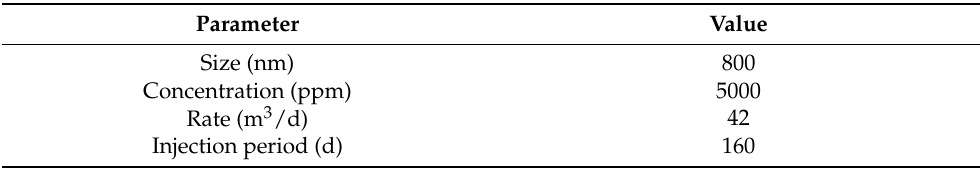
Table 4. PMs injection scheme of